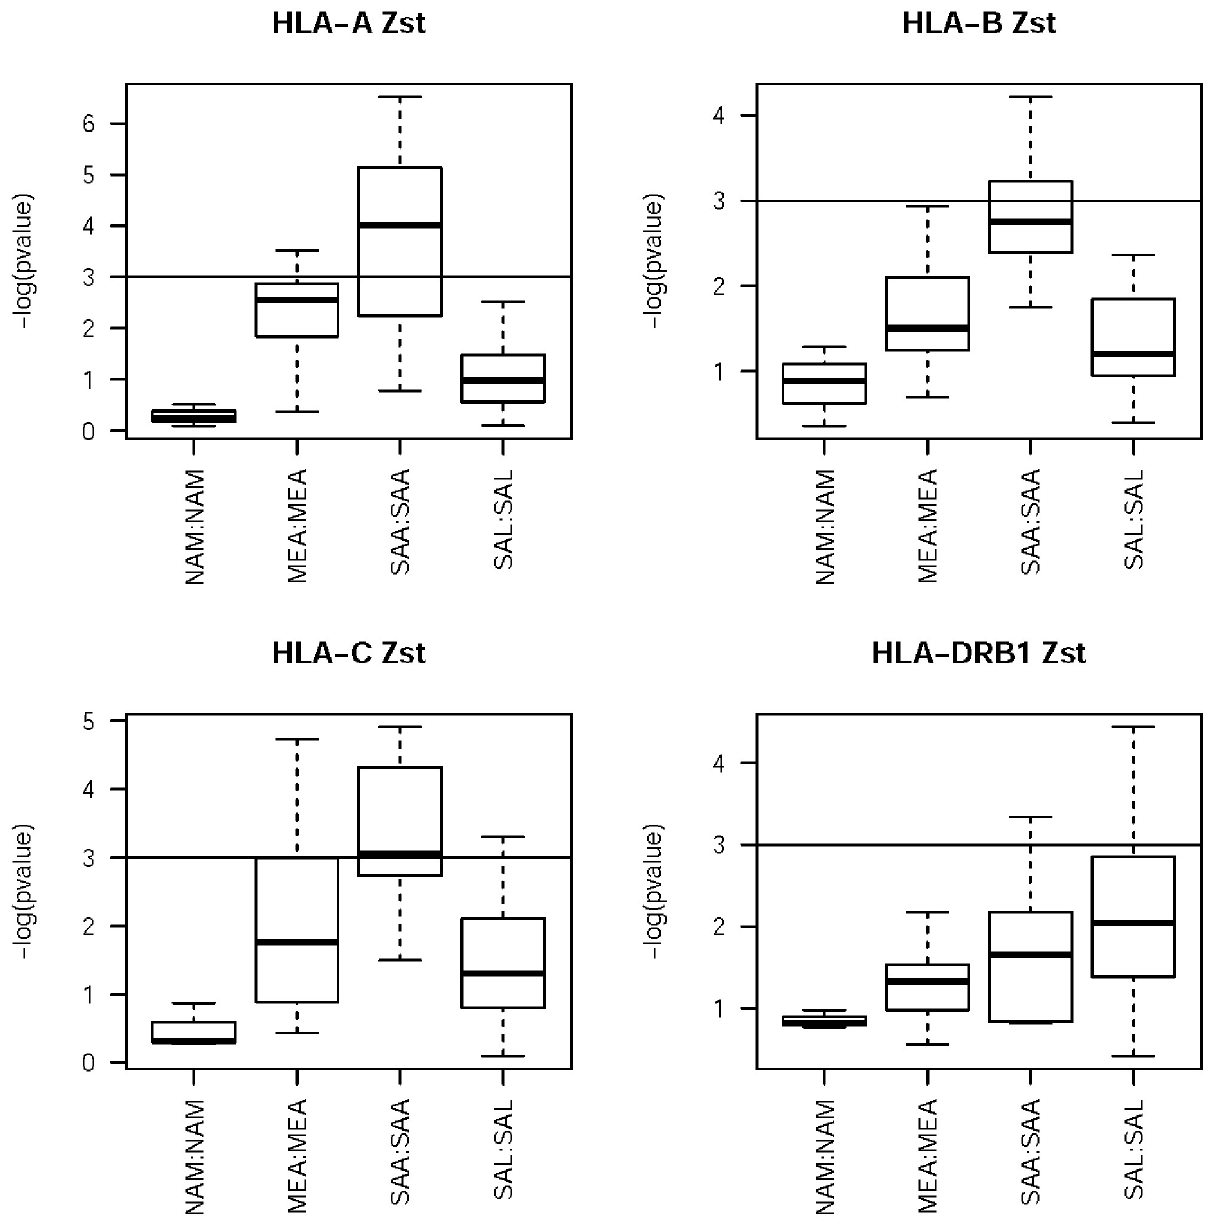
Fig 7. Z ST values by region and locus. Empirical p-value from the distribution of microsatellite F ST s . Z ST measures the number of standard deviations the HLA F values are from that of the neutral loci. The line at–log(p-value) = 3 corresponds to the 0.05 level of ST